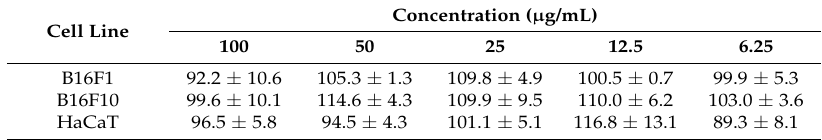
Table 3. Viabilities of three cell lines treated with different concentrations of (3R)-5-hydroxymellein. Cell Line